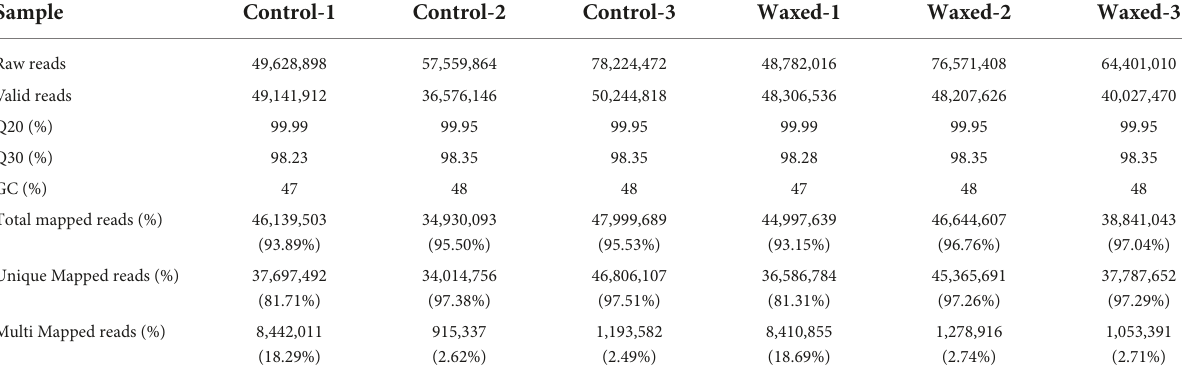
TABLE 1 Summary of RNA-sequencing of apple fruit waxing treatment.